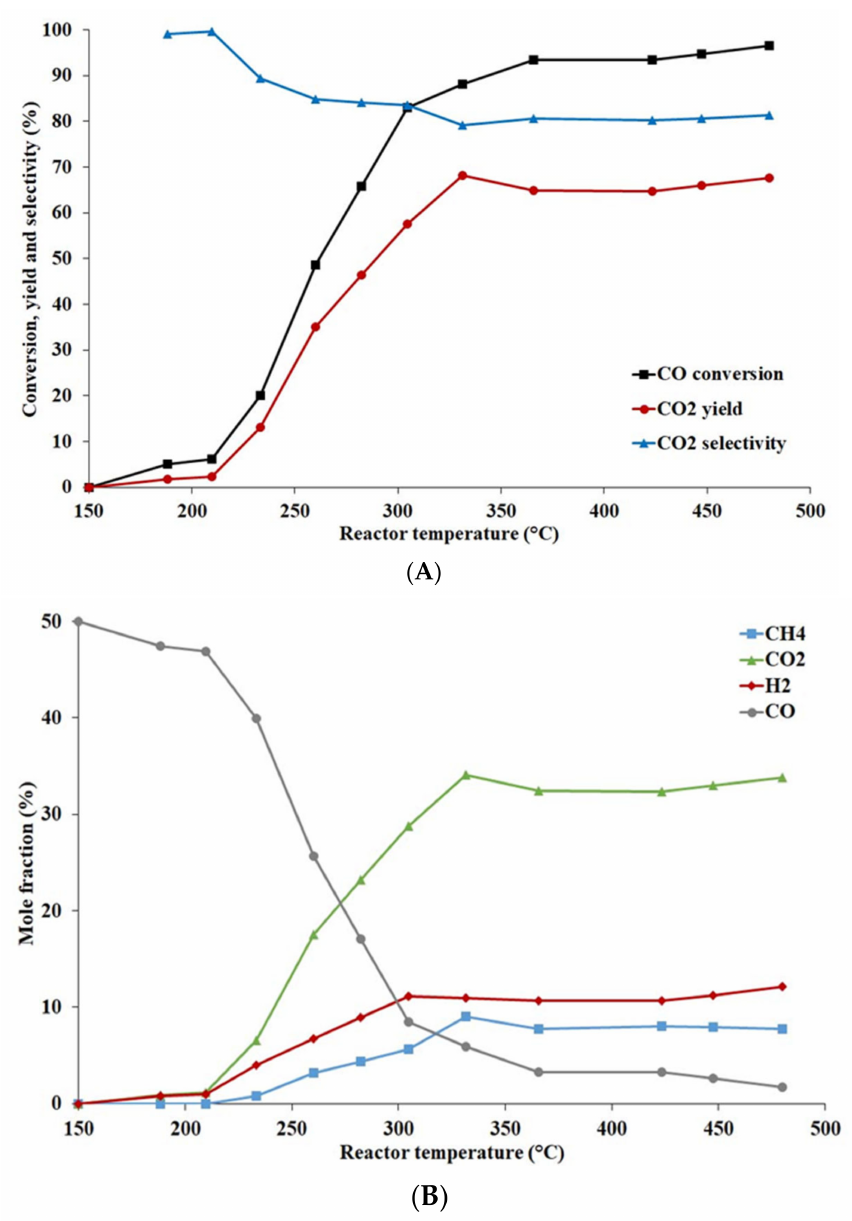
Figure 2. Catalytic tests with feed gas mixture 1 (50 mole% CO and 50 mole% N 2 ) at pressure 0.5 MPa over a commercial Ni-based catalyst: ( A )—CO conversion, CO 2 yield, and CO 2 selectivity; ( B )—composition of the gas